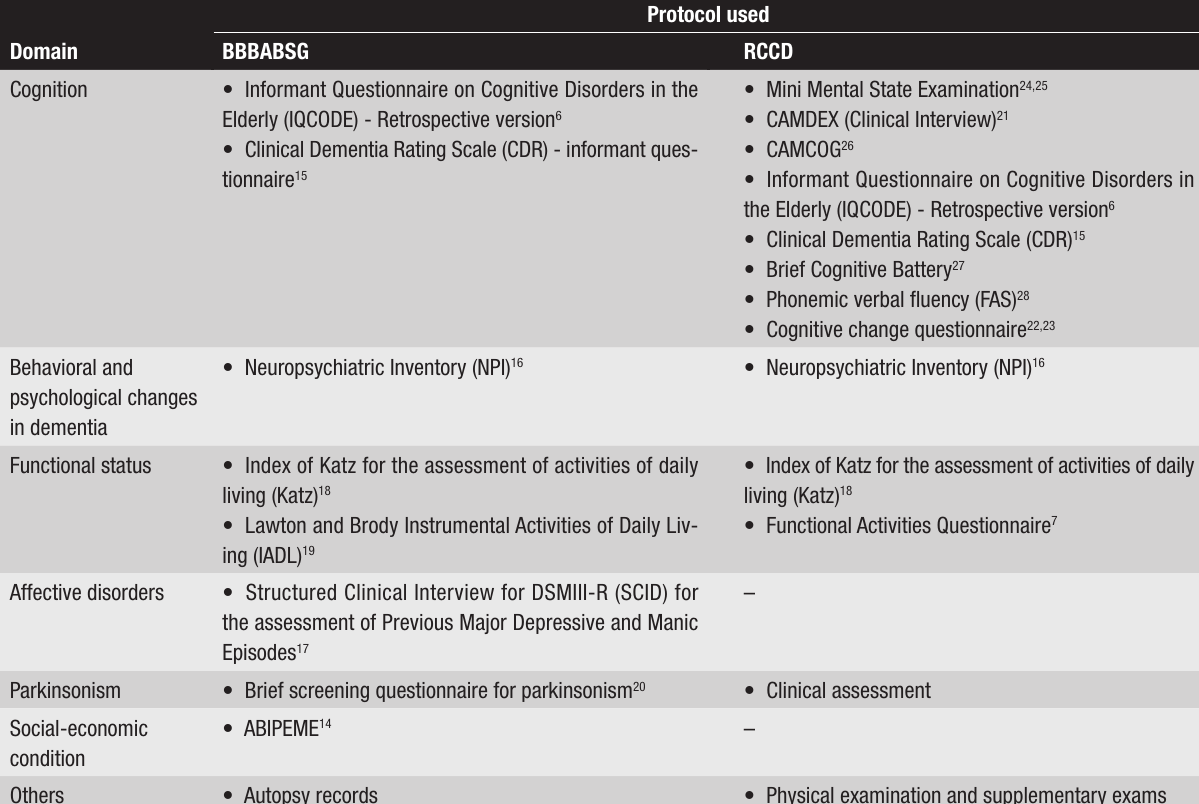
Figure 1. Protocols used by the Brazilian Brain Bank of the Aging Brain Study Group (BBBABSG) and Reference Center for Cognitive Disorders (RCCD), for clinical and functional assessment. CAMCOG, Cambridge Cognitive Examination; CAMDEX, The Cambridge Mental Disorders of the Elderly